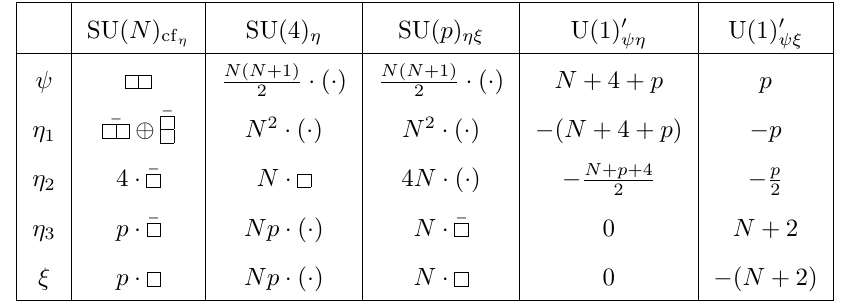
Table 8 . UV fieds in the BY model, decomposed as a direct sum of the representations of the unbroken group of eq. (F.4).